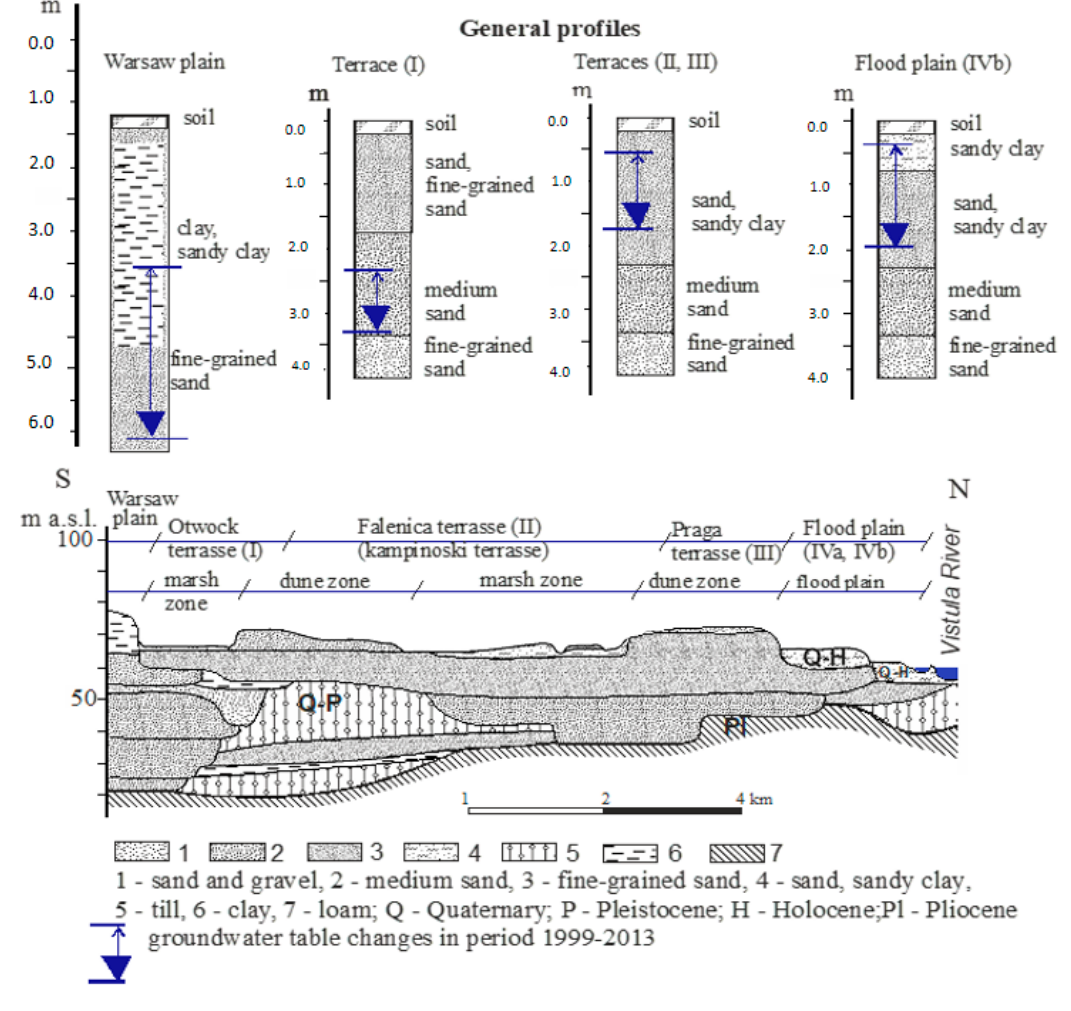
Figure 3. Groundwater condition scheme in the study area (adapted from